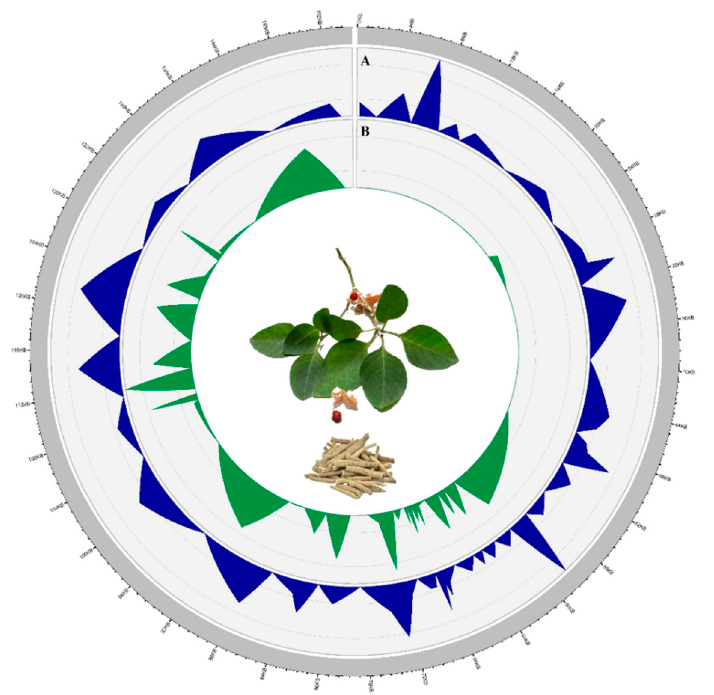
Figure 4. Circular visualization of the distribution of polymorphisms among Withania species.